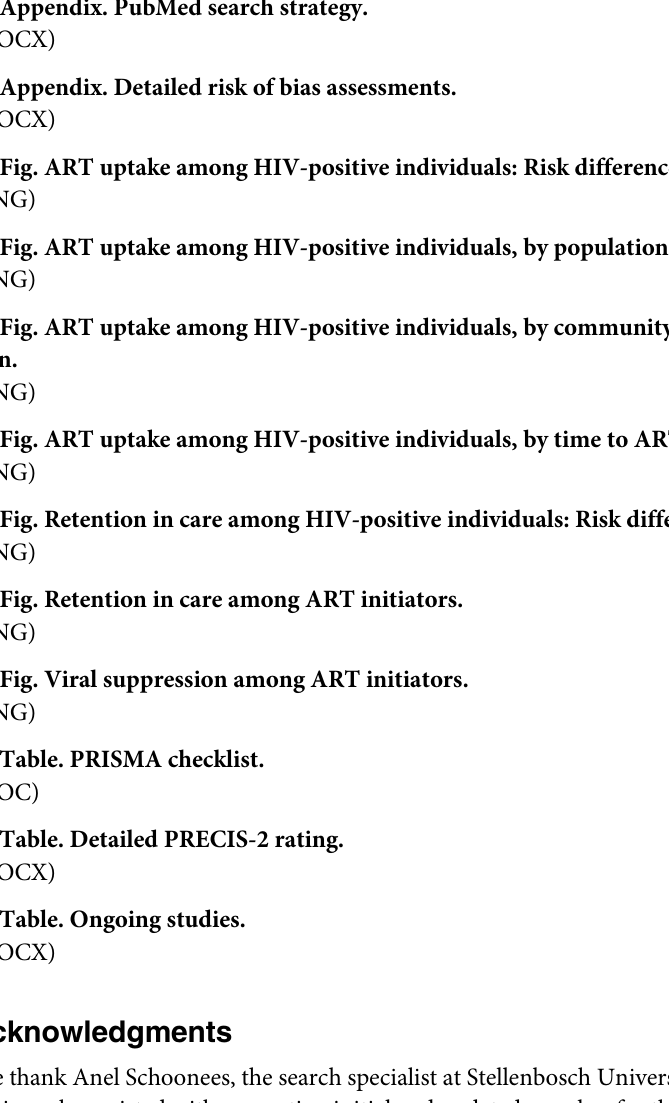
S5 Fig. Retention in care among HIV-positive individuals: Risk difference. S6 Fig. Retention in care among ART initiators. S7 Fig. Viral suppression among ART